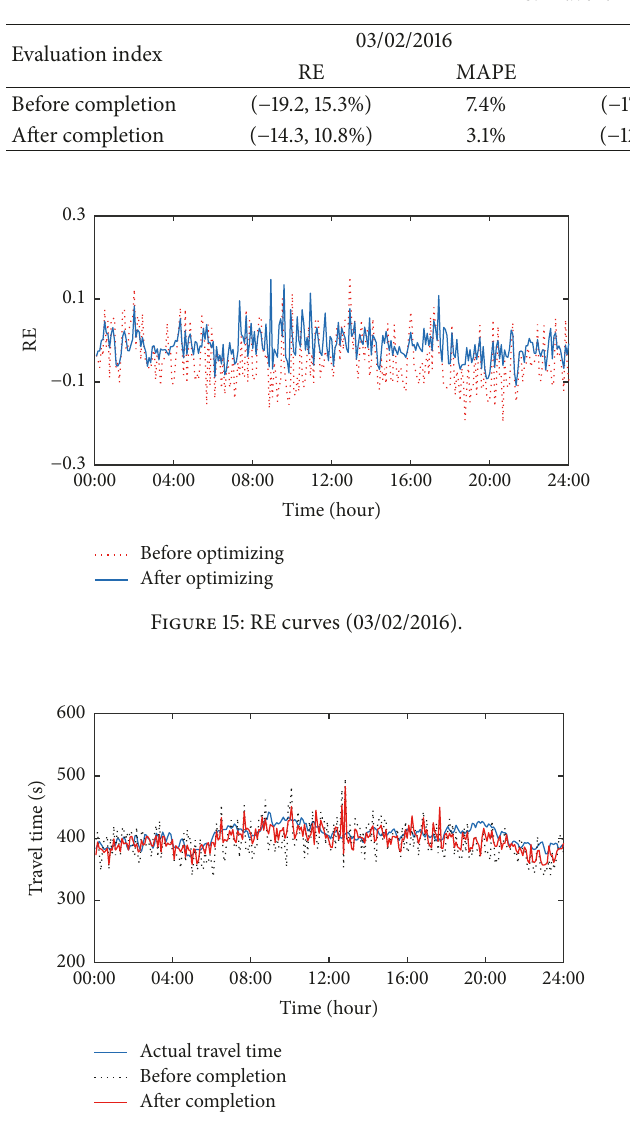
Figure 16: Travel time prediction result curves (03/04/2016).